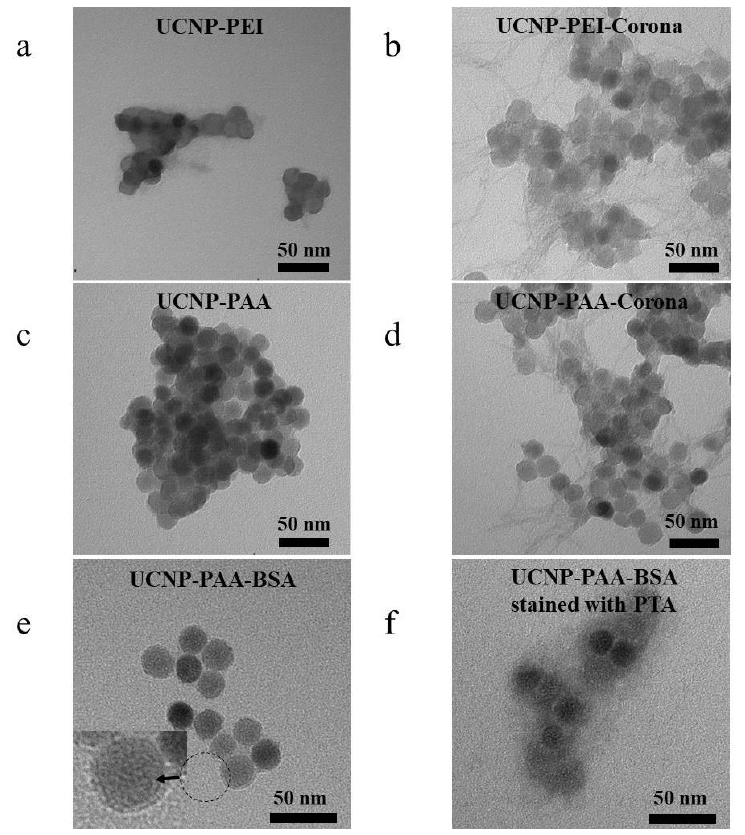
Figure 1. TEM images of UCNP-PEI ( a ), UCNP-PEI-PC ( b ), UCNP-PAA ( c ), UCNP-PAA-PC ( d ), UCNP-PAA-BSA corona ( e ), and UCNP-PAA-BSA corona subjected to negative staining with 2% PTA ( f